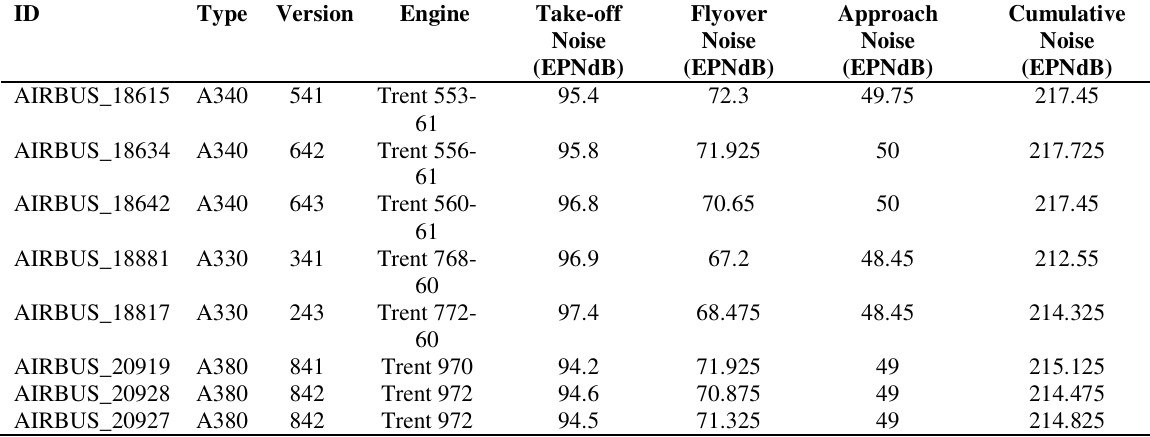
Engine noise level of the real engine from engineering calculations [11]